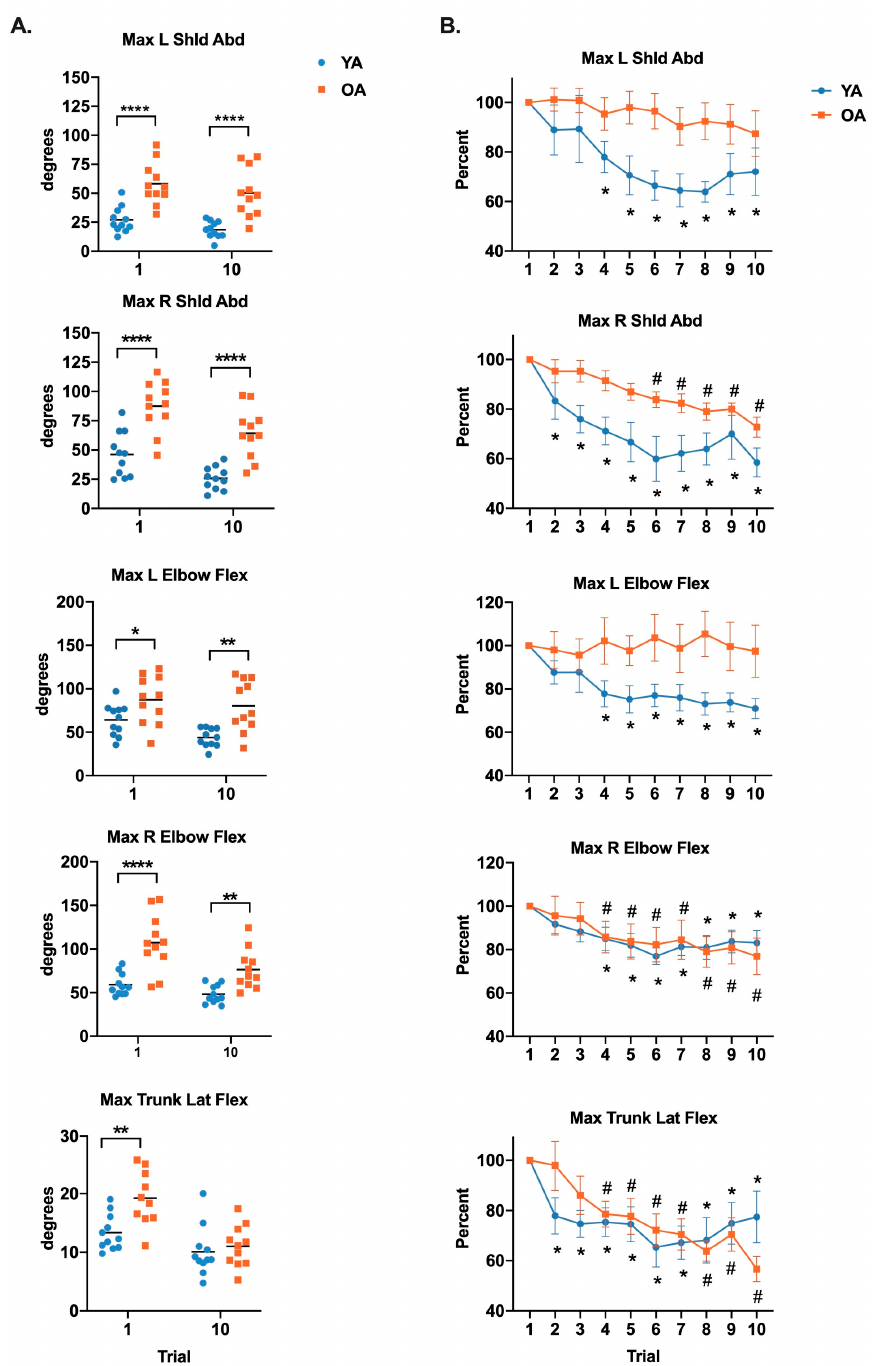
Figure 1. Age-related differences in displacements of shoulder abduction, elbow flexion, and left lateral trunk flexion during trials 1 and 10 ( A ) and within-group habituation over 10 successive trials ( B ). Values in scatterplots in the left column are expressed as the mean (horizontal lines) and individual data points. Values in the right column are expressed as the mean +/ − standard error. Left column, corrected p -values depict differences between young and older adults. * p < 0.05, ** p < 0.01, and **** p < 0.0001. Right column corrected p -values depict within-group differences between trial 1 and each of the subsequent trials. * p < 0.05 in young group and # p < 0.05 in older group.